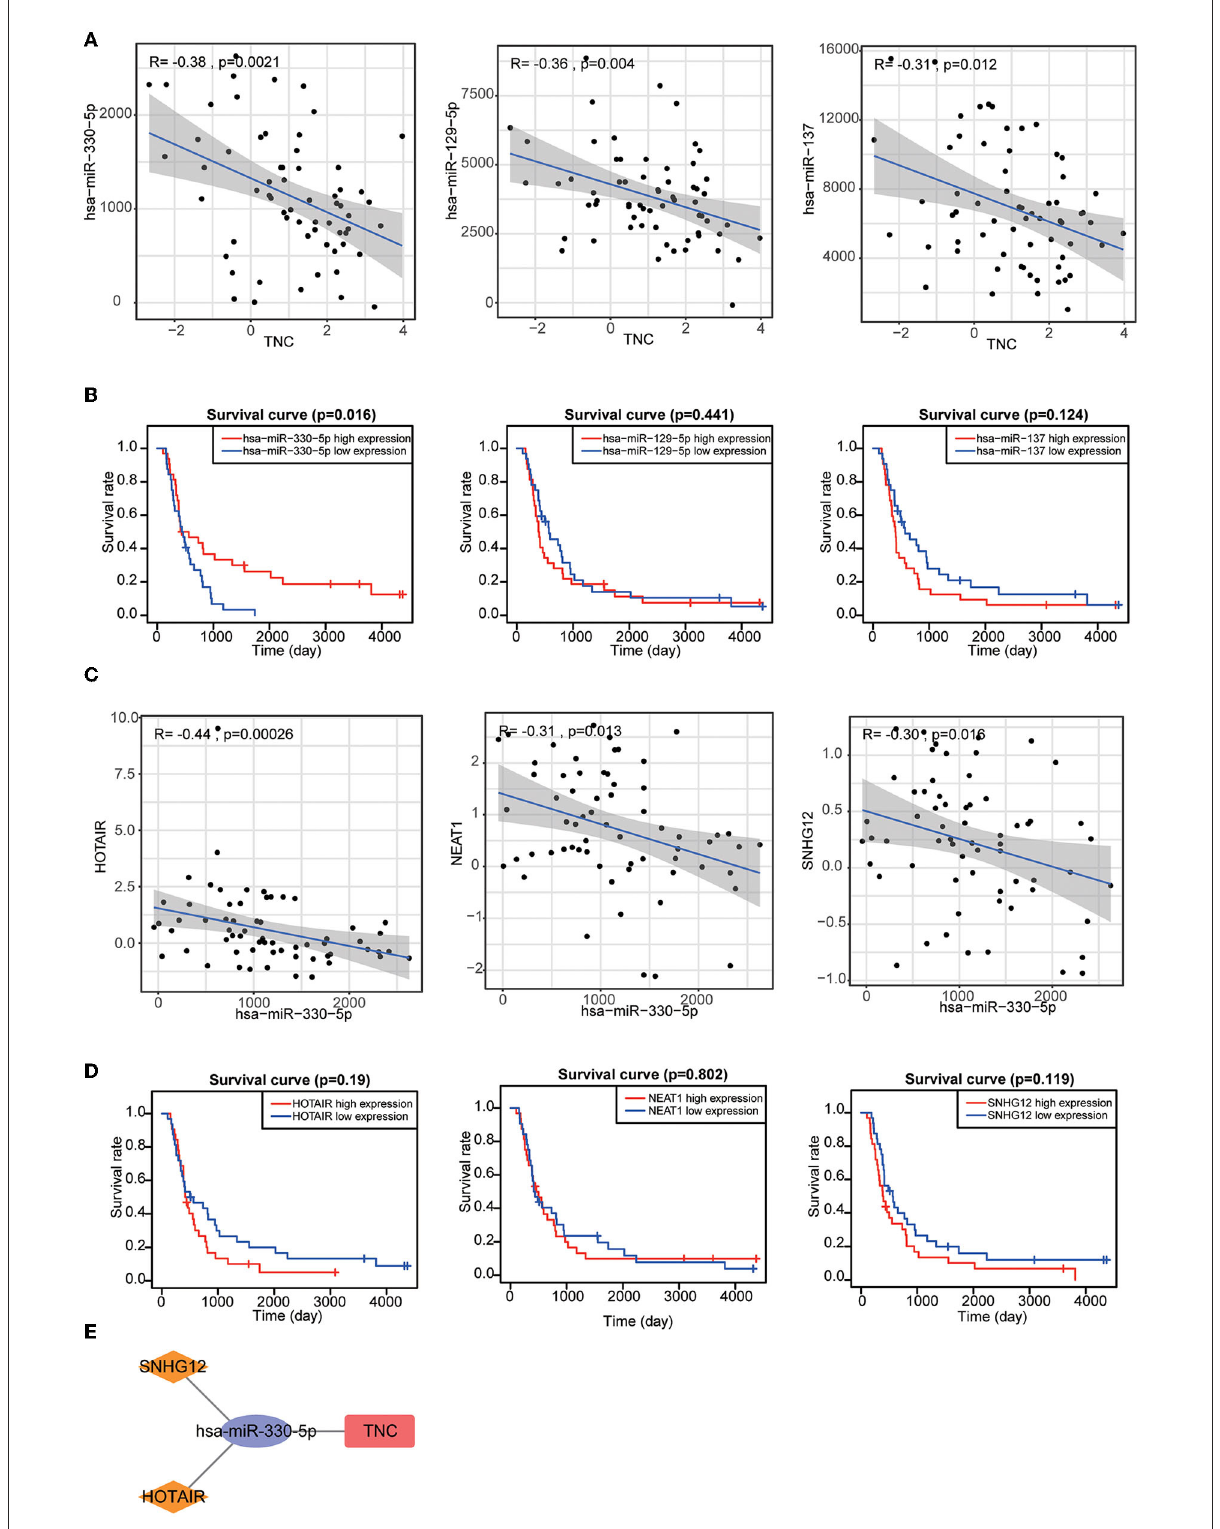
FIGURE9 (A) Target miRNAs significantly negatively correlated with TNC. (B) KM curves of TNC-targeting miRNAs. (C) Target lncRNAs significantly negatively correlated with miR-330-5p. (D) KM curves of miR-330-5p-targeting lncRNAs. (E) HOTAIR and SNHG12 can regulate TNC expression by competitively binding to